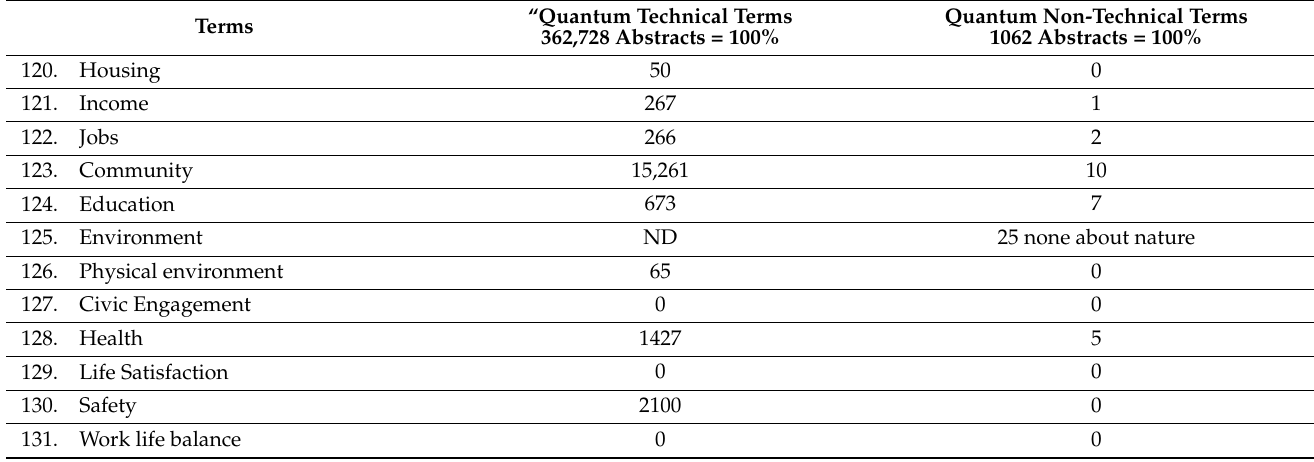
Table 7. Presence of Better Life Index indicators in conjunction with quantum terms